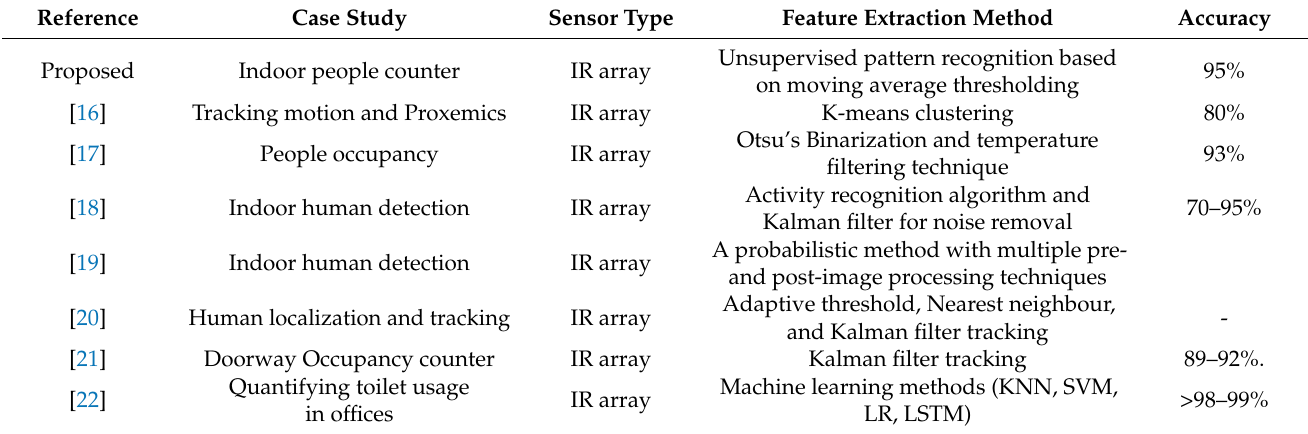
Table 1. A comparison between 8 × 8 pixels thermopile IR sensors array methods reported in literature for human detection.